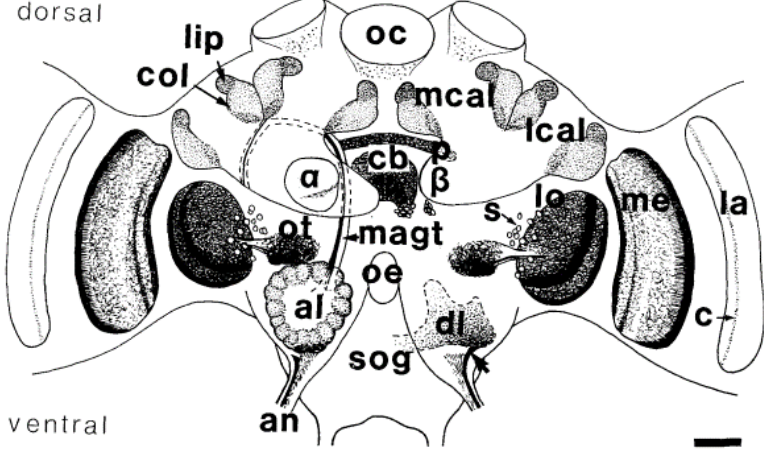
Figure 1. Schematic drawings of acetylcholinesterase (AchE) labelling in the neuropiles and some prominent groups of somata in the bee’s brain in a frontal view. The optic lobes lamina (la), medulla (me), and lobula (lo) display layered AChE staining. Weak AChE staining was found in the synaptic plexus of the ocelli (oc). The lobula is connected to the optic tubercle (ot). AChE-positive sensory fibres (arrow) of the antennal nerve project into the dorsal lobe (dl) and the suboesophageal ganglion (sog) below the oesophagus (oe). The median antennoglomerular tract (magt) connects the glomeruli of the antennal lobe (al) with the lip area (lip) of the median (mcal) and lateral calyx (Ical) of the mushroom bodies (MB). The collar (col) is a neuropilar compartment of the calyx receiving visual input. AChE-positive fibres leave the β -lobe ( β ) of the mushroom body. The central complex shows AChE activity in the pons (p), central body (cb) and a group of somata (s) ventrally to the central body. C-layer (c), α -lobe ( α ), antennal nerve (an). Scale = 100 µ m (reproduced from [31] with permission by John Wiley and Sons).